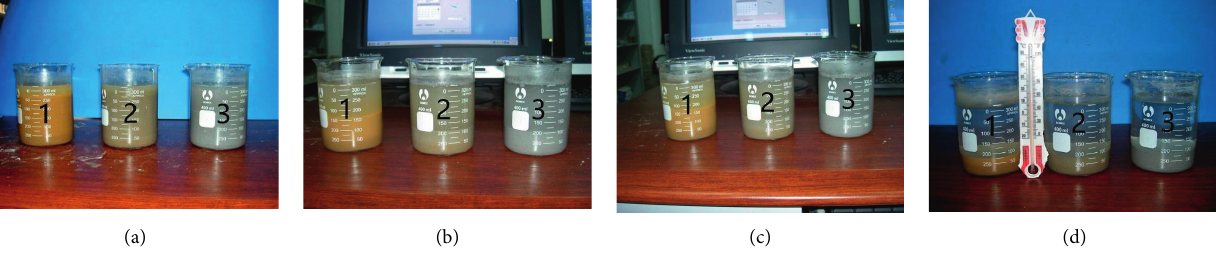
Figure 6: Experimental Table 4: Precipitation time and speed of fly ash slurry.